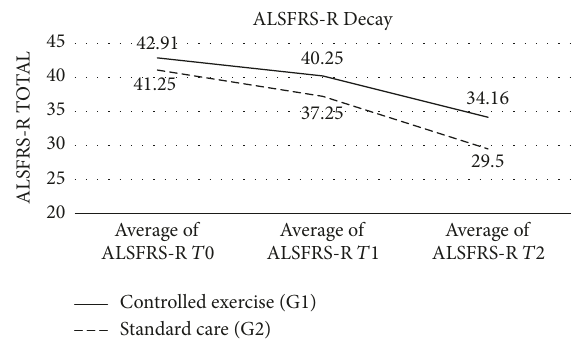
Figure 2: Slope of ALSFRS-R total score between T 0, T 1, and T 2 for both groups.